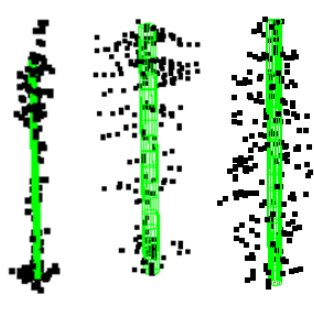
Figure 3: Axes of point clouds determined by Sample Consensus.